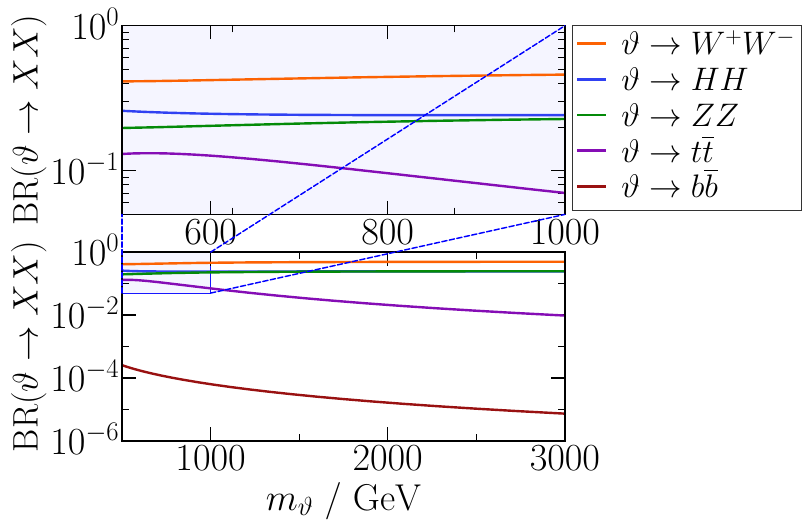
Figure 5. Tree-level flavon BRs for the case m ϑ < 2 M Z 0 so that the flavon is unable to decay into a pair of on-shell Z 0 bosons. The three leading final states, WW , ZZ and hh , come in the approximate ratio 2:1:1. The upper panel is an enlargened version of the shaded region of the lower